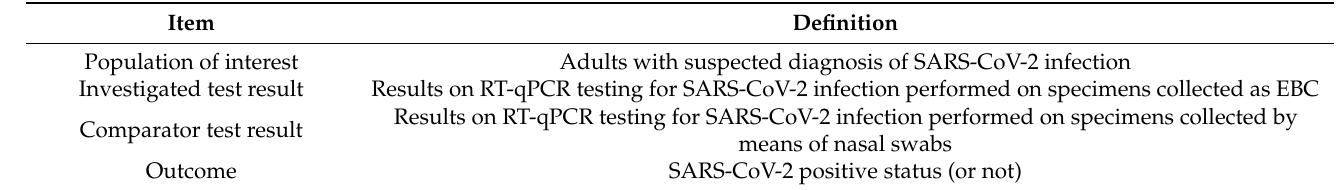
Table 1. A PICO worksheet modified for studies on diagnostic tests [26] (Note: EBC = exhaled breath condensate; RT-qPCR = polymerase chain reaction